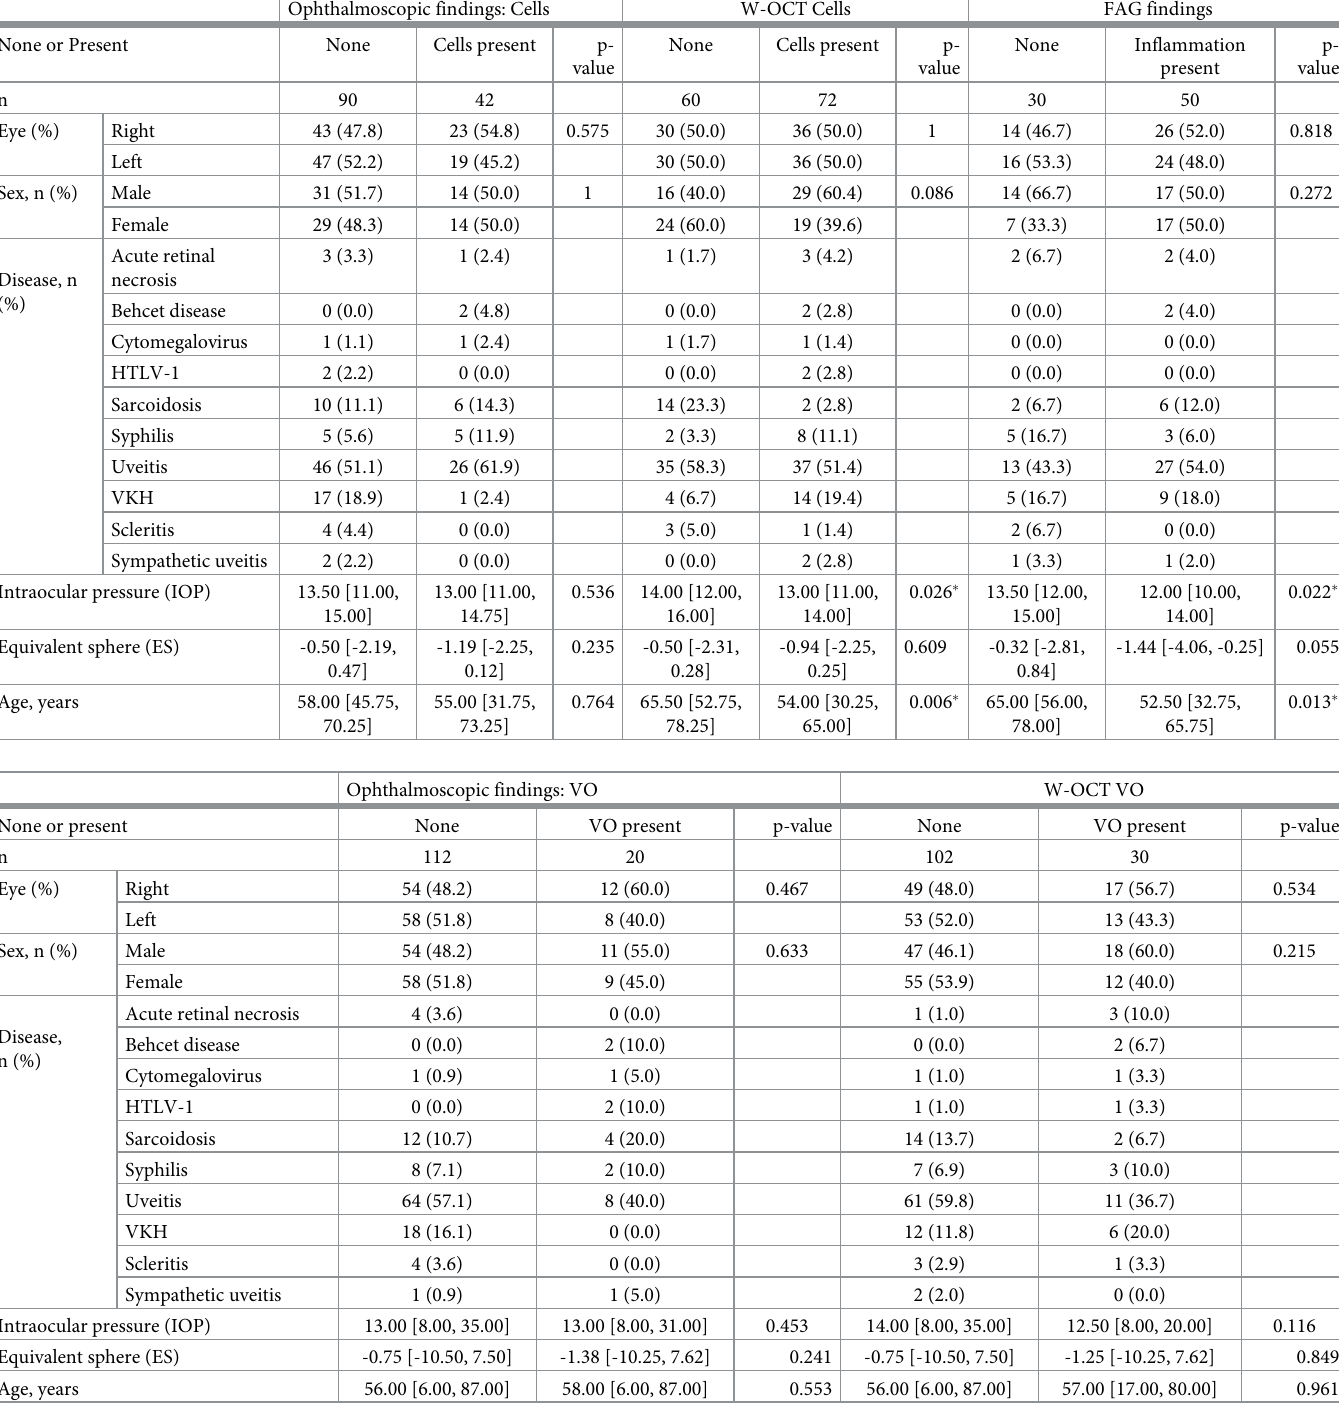
Table 2. Characteristics by examination. IOP, ES, and age are shown as median and quartiles. Statistical comparisons were performed using the χ 2 test. Significant differ- ences in IOP and ES were observed between W-OCT and FAG findings. Ophthalmoscopic findings: Cells W-OCT Cells FAG